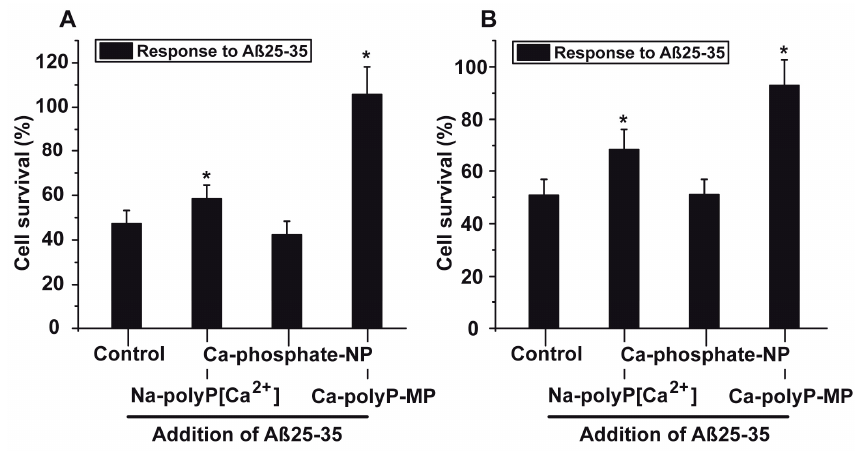
Figure 5. Protective effect of polyP against the toxic effect displayed by the fragment of the amyloid β -protein; the experiments were performed with ( A ) PC12 cells or with ( B ) primary rat cortex neurons. The cells remained either untreated, or were pre-incubated with 30 μ g/mL of the phosphate/polyP samples (either Na-polyP[Ca 2+ ], Ca-phosphate-NP, or Ca-polyP-MP) for 24 h. Then the cells, at a concentration of 8 × 10 4 cells/mL, were incubated with the 6 h pre-incubated A β 25-35 fragment. After a following period of 12 h the viability of the cells in the respective assays was determined with the MTT assay. From those values, the cell survival rate was calculated and the values are given in % of the respective controls (without phosphate/polyP and A β 25-35). Data ± SD (ten independent experiments) are give; the significance (*) is calculated p < 0.05.